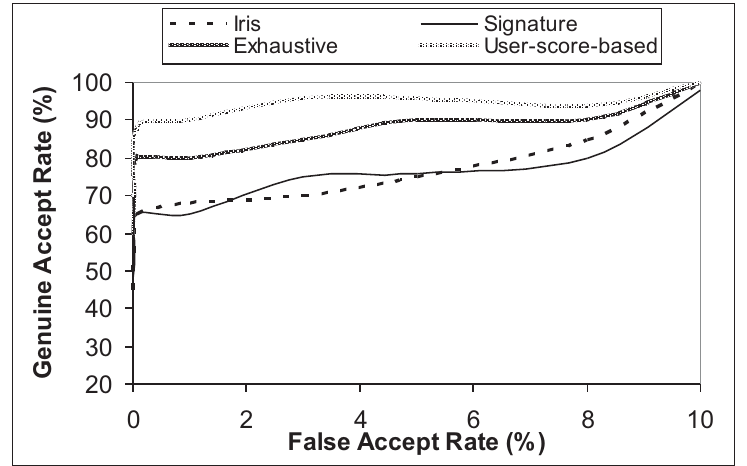
Tanh normalized-based ROC curves showing the performance of using Iris, Signature, Iris + Signature (Exhaustive), and Iris + Signature (User-score-based).